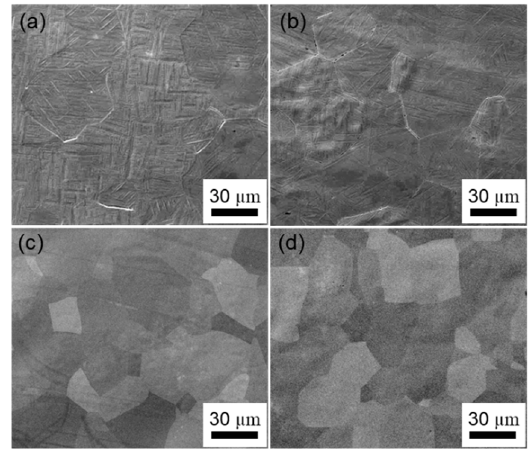
Figure 3. SEM micrographs of Ti–Nb–12Zr alloys: ( a ) Ti–15Nb–12Zr; ( b ) Ti–16Nb–12Zr; ( c ) Ti–17Nb–12Zr; ( d ) Ti–18Nb–12Zr alloys.